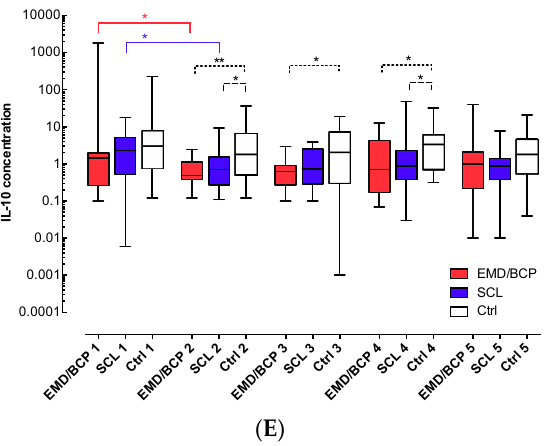
Figure 2. ( A ) Concentration of TNF- α in GCF/WF samples; ( B ) Total amount of TNF- α in GCF/WF samples; ( C ) Concentration of IL-6 in GCF/WF samples; ( D ) Total amount of IL-6 in GCF/WF samples; ( E) Concentration of IL-10 in GCF/WF samples. EMD/BCP (enamel matrix derivative/biphasic calcium phosphate): red, SCL (surgical crown lengthening): blue, Ctrl (control): white; GCF/WF: gingival crevicular fluid/wound fluid; TNF- α : Tumour necrosis factor α ; IL-6: Interleukin 6; IL-10: Interleukin 10; *: p < 0.05; **: p < 0.01, ***: p < 0.001.